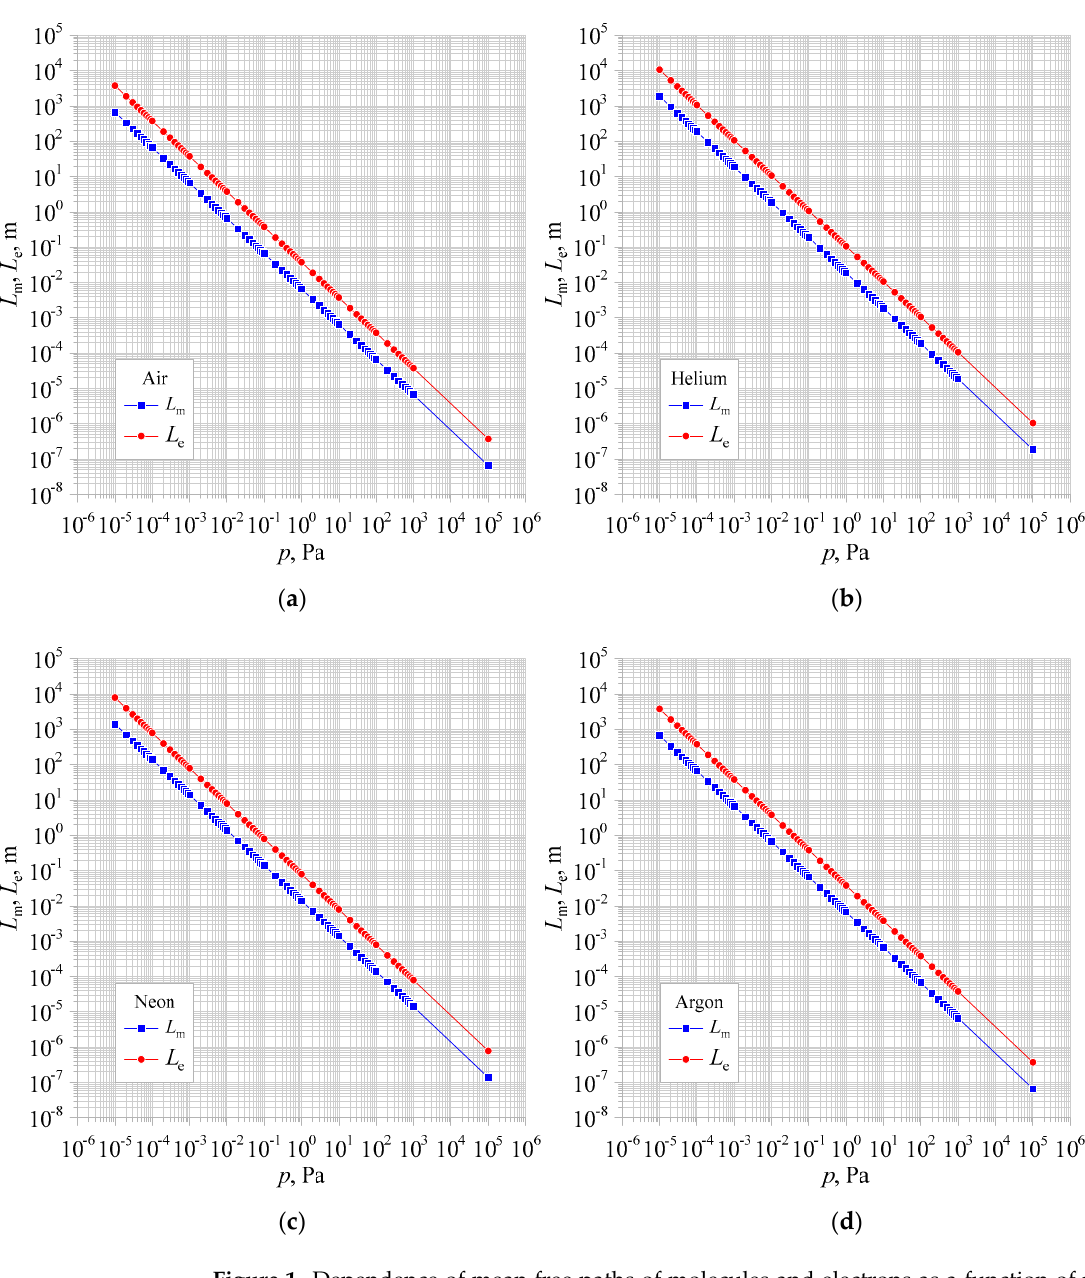
Figure 1. Dependence of mean free paths of molecules and electrons as a function of pressure of selected gases: ( a ) air, ( b ) helium, ( c ) neon, ( d ) argon.